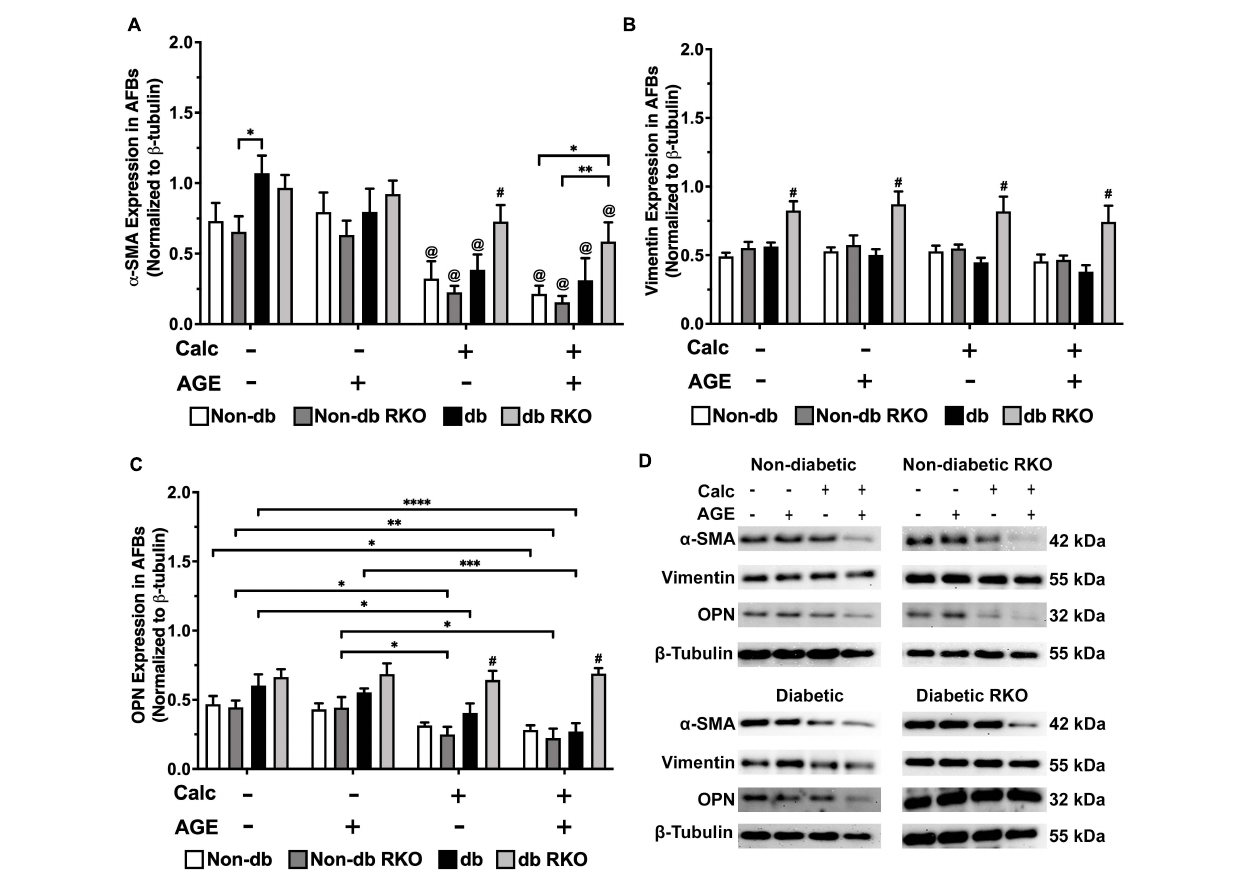
FIGURE 6 | Adventitial fibroblasts respond to calcification by a loss of phenotype markers. Protein expression of α -SMA (42 kDa; A ), vimentin (55 kDa; B ), and OPN (32 kDa; C ) was quantified. Non-diabetic, non-diabetic RKO, diabetic, and diabetic RKO primary AFBs were isolated and treated with 3 mM P i with or without AGEs (0.5 mg/mL) for 7 days. Protein levels were normalized to β -tubulin (D) and graphed as mean ± SEM with n = 6–9 of independent replicates. Statistical analysis consisted of a two-way ANOVA and a Fisher’s LSD test post hoc ( # p < 0.05 toward all other groups in treatment group, @ p < 0.05 toward no calcification treatments within genotype, * p < 0.05, ** p < 0.01, *** p < 0.001, **** p <